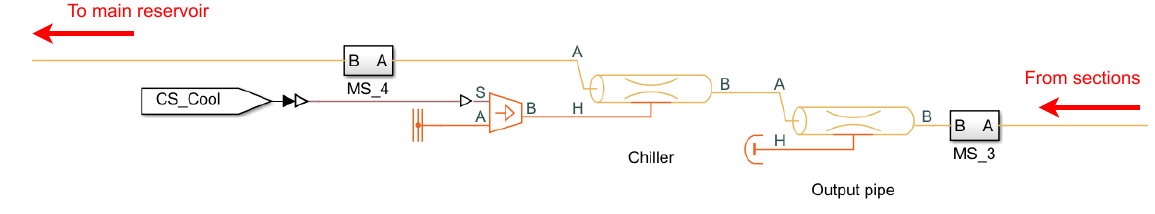
Figure 10. The chiller